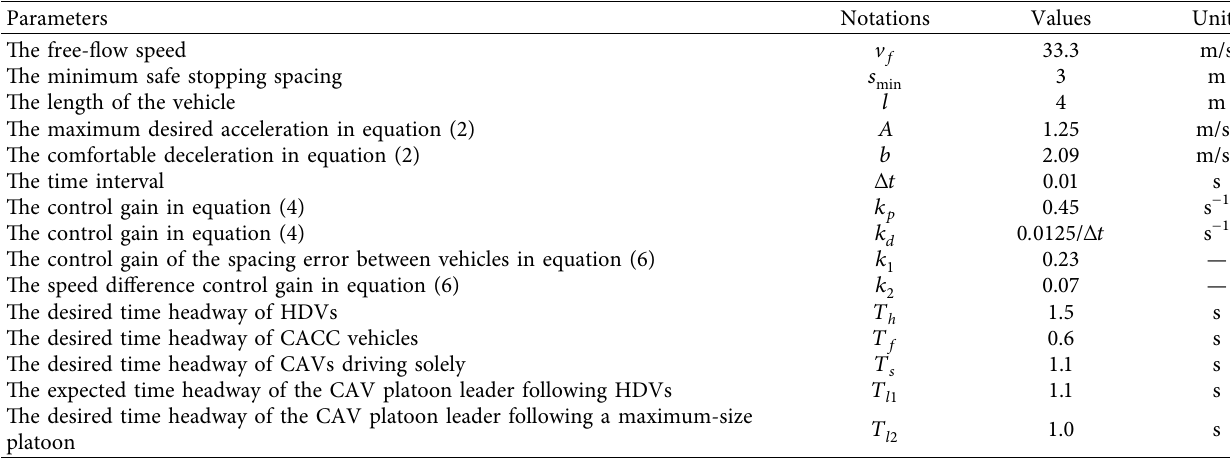
Table 2: Parameter settings for sensitivity